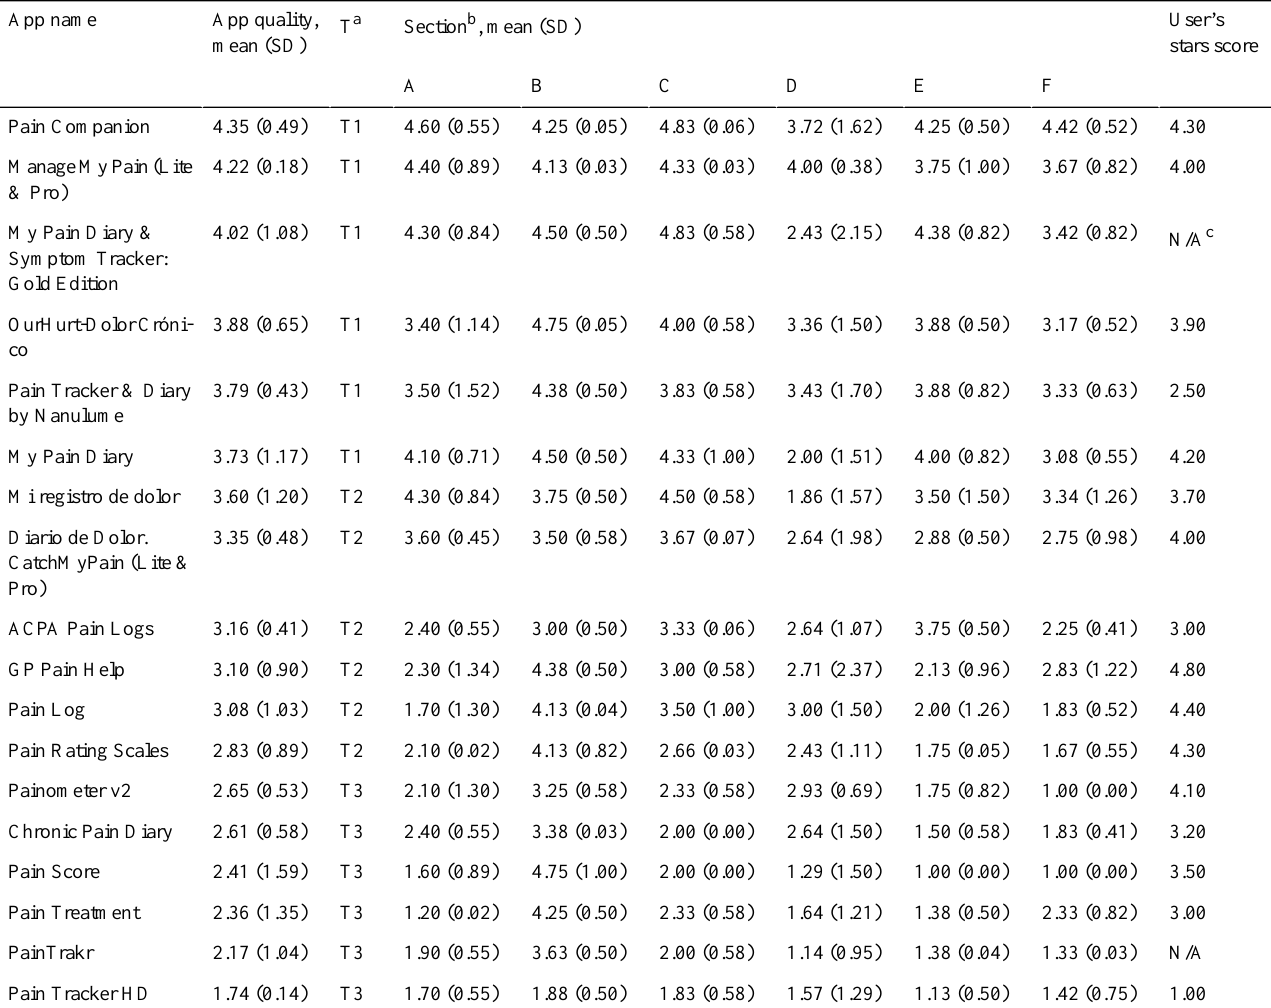
Table 4. Mobile App Rating Scale (MARS) scoring of the pain-related apps.